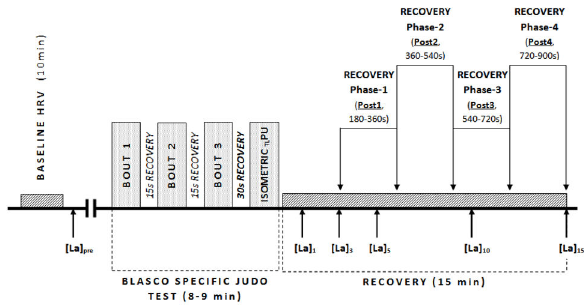
Figure 1. Schematic view of the experimental